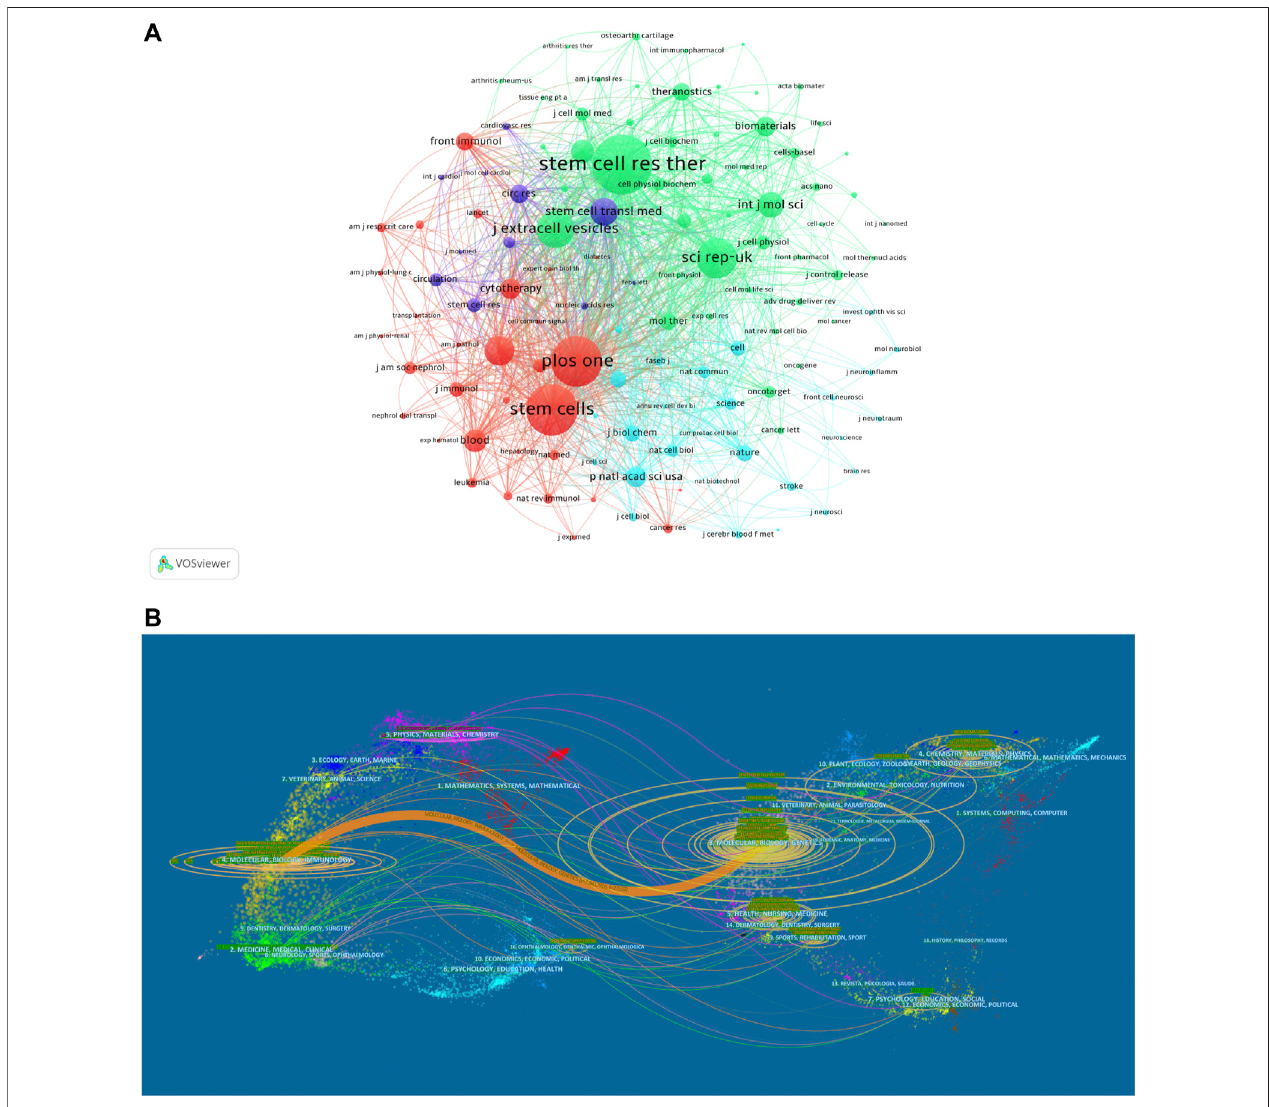
FIGURE 4 | Articles published in different journals on MSC-EVs. (A) Network map of journals that were co-cited in more than 150 publications. (B) The dual-map overlay of journals related to MSC-EVs.